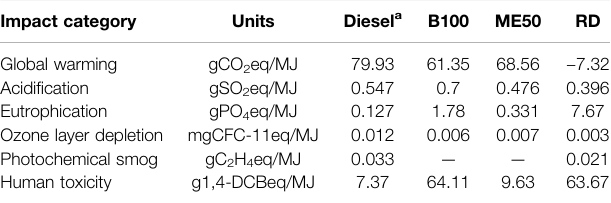
TABLE 3 | Emissions in the impact